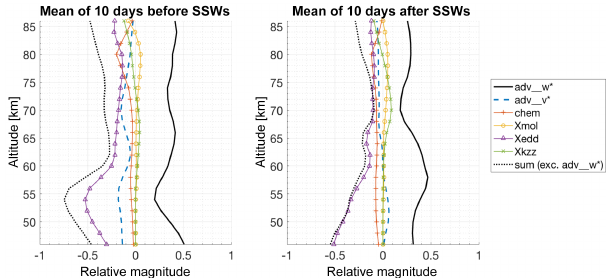
Figure 11. Same as Fig. 9 (60–90 ◦ N), but for the 10 days directly before and after SSWs within Jan 2008 to April 2014. See Sect.